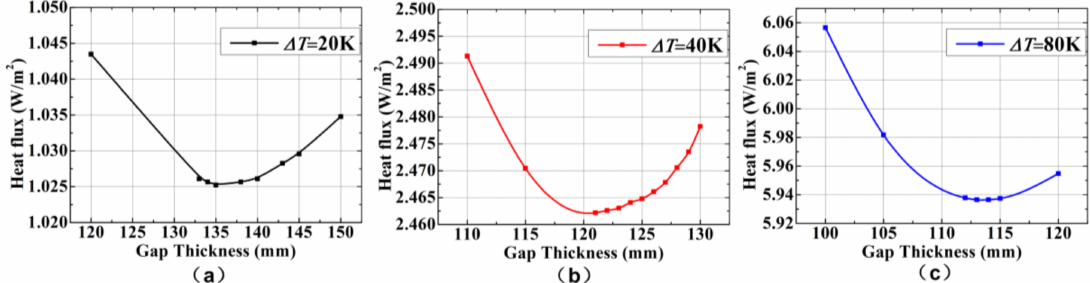
Figure 9. Variation in heat flux with the vertical enclosure gap thickness near the critical enclosure thickness: ( a ) ∆ T = 20 K; ( b ) ∆ T = 40 K; ( c ) ∆ T = 80